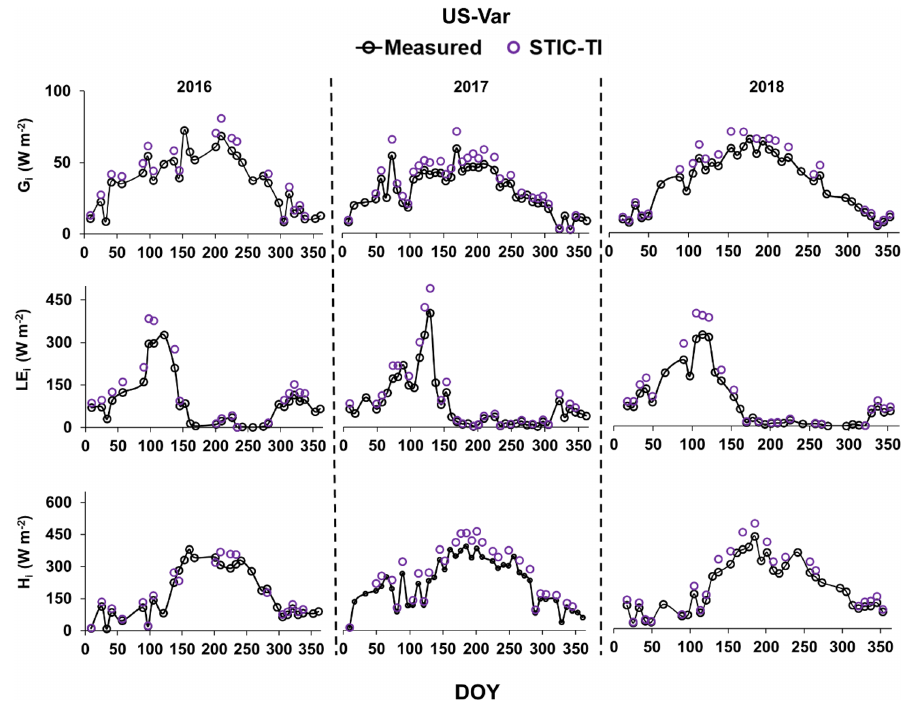
Figure 10. Illustrative examples of the temporal evolution of STIC-TI-derived fluxes using the MYD11A2 LST product versus observed SEB fluxes for 3 consecutive years from 2016 to 2018 in a grassland ecosystem in the United States (e.g., US-Var).